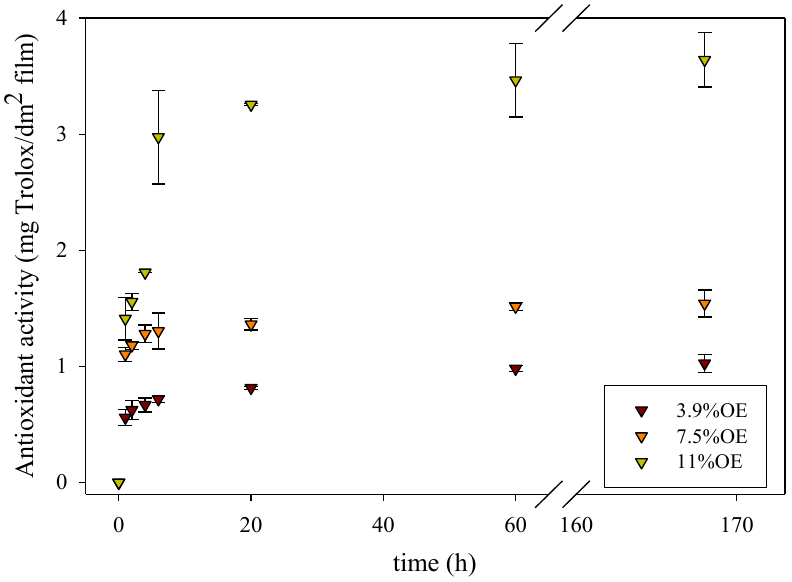
Figure 2. Kinetic of antioxidant activity of food simulants exposed to cellulose acetate-based films with 35% TEC (w TEC /w polymer ) and three onion extract concentrations (%OE w onion /w polymer ).